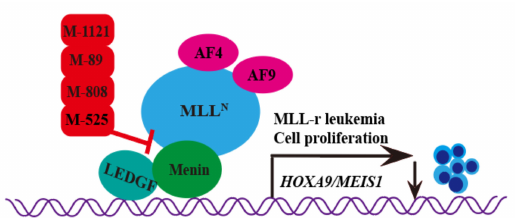
Figure 1. Molecular mechanisms of Hydroxymethyl and aminomethyl piperidine inhibitors in treating leukemia and cancers. Four inhibitors, M-525, M-808, M-89, and M-1121, block the interaction between menin and MLL-AF4, MLL-AF9 fusion protein to reduce the expression of MEIS1 and HOXA9 genes and inhibit the proliferation of MLL-r leukemia